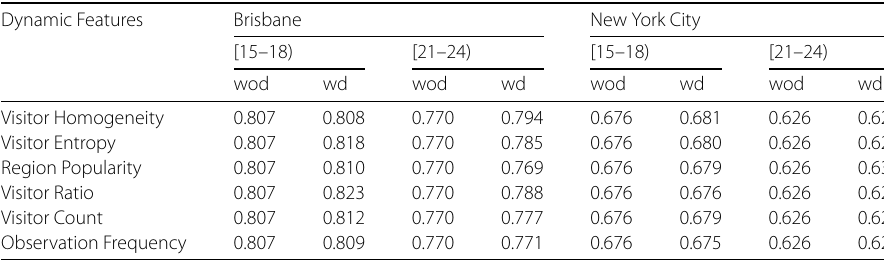
Table 9 The AUC with and without individual dynamic feature for Theft prediction Dynamic Features